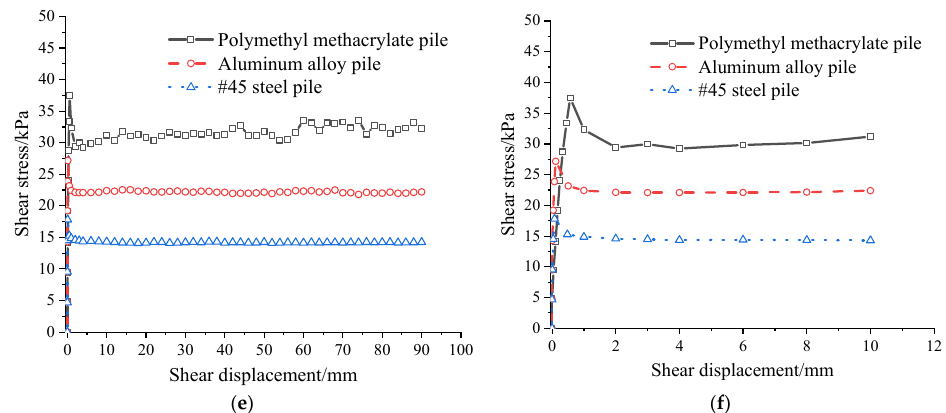
Figure 5. Shear stress ‒ shear displacement curves for different surface hardness. ( a ) Fine sand (0~90 mm). ( b ) Fine sand (0~10 mm). ( c ) Medium sand (0~90 mm). ( d ) Medium sand (0~10 mm). ( e ) Coarse sand (0~90 mm). ( f ) Coarse sand (0~10